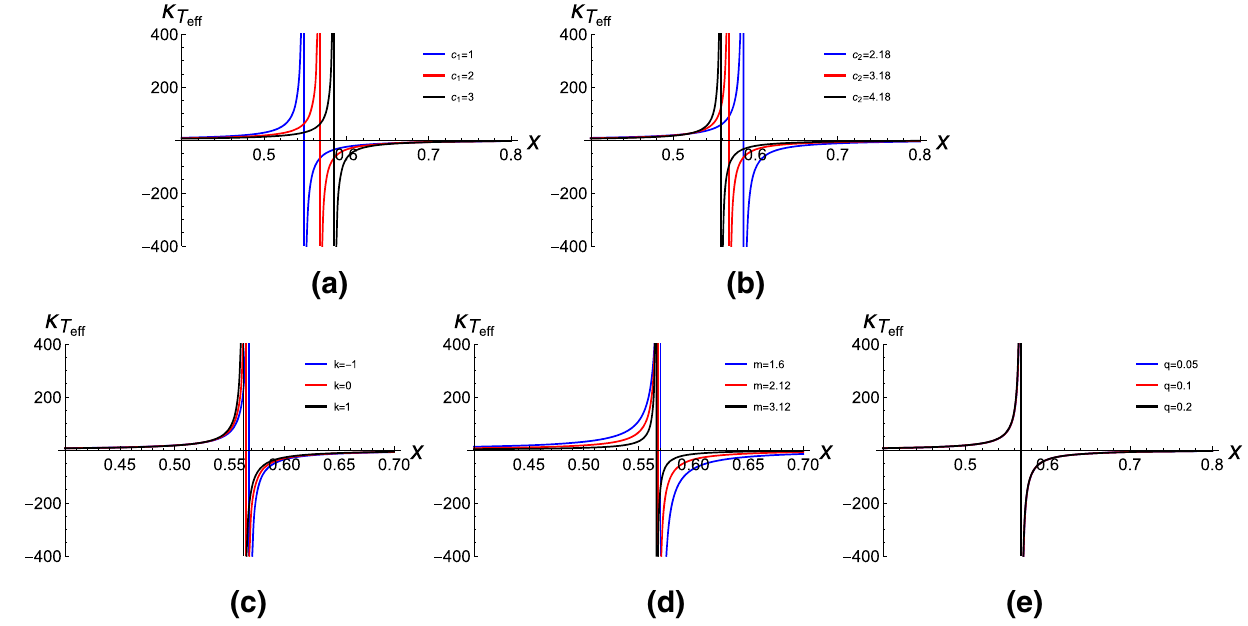
− x diagrams when the parameters change respectively and the initial parameters m = 2 . 12, c Fig. 6 κ T eff k =